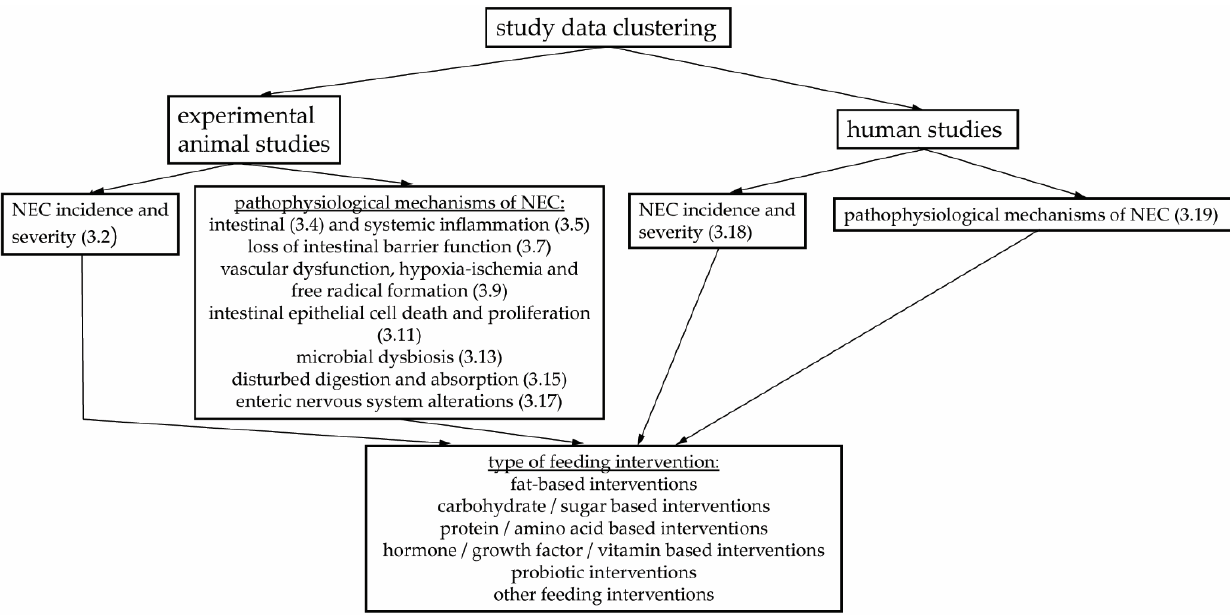
Figure 1. Overview of clustering of extracted data. The number in parentheses refers to the result section the data is incorporated in.